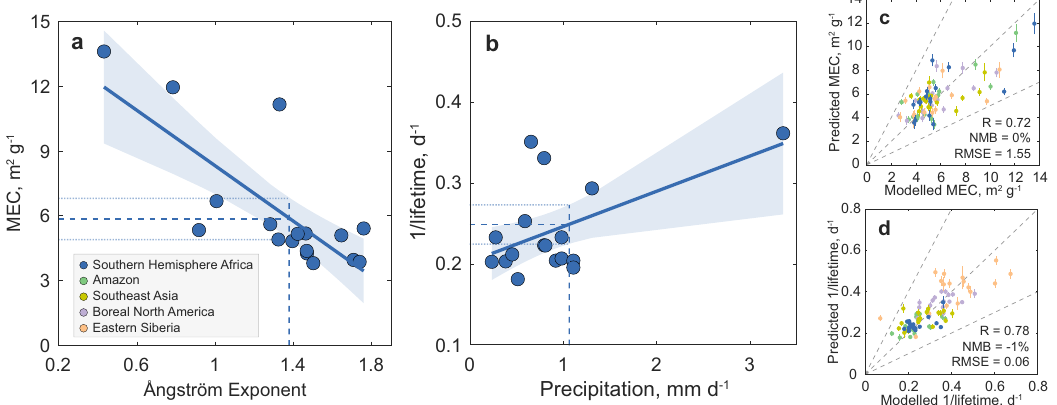
Fig. 2 | Linear regressions developed over AeroCom models to estimate the constrained mass extinction coef fi cient (MEC) and lifetime. a The linear regression for MEC over Ångström Exponent. b The linear regression for lifetime over precipitation. Note that the real lifetime regression uses both precipitation and the Ångström Exponent as predictors given the regression improvement (Supplementary Fig. 2). In a and b , the regressions are shown for Southern Hemi- sphere Africa as an example with each dot indicating the regional and fi re-season mean values in one model. The solid lines indicate the linear regressions together with the 95% con fi dence intervals (shaded areas). The regional mean observations